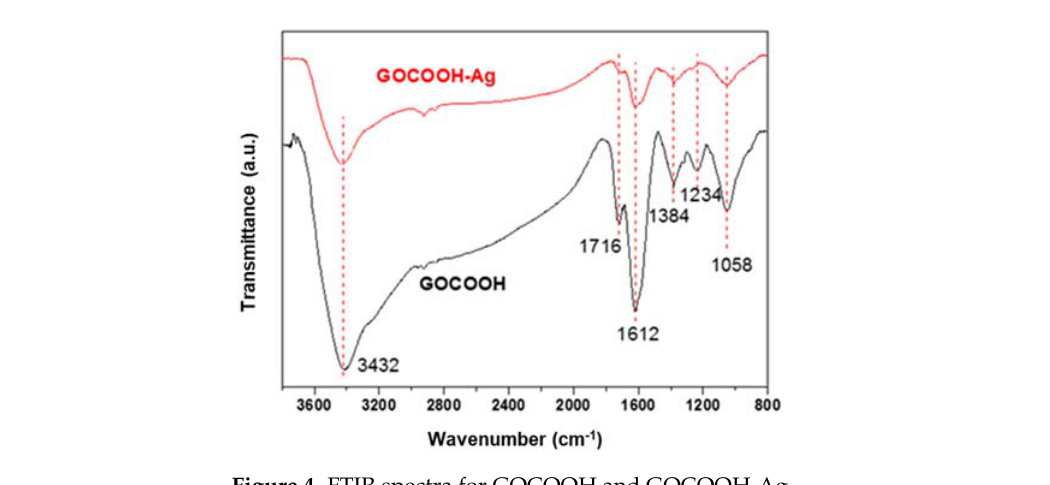
Figure 4. FTIR spectra for GOCOOH and GOCOOH-Ag.